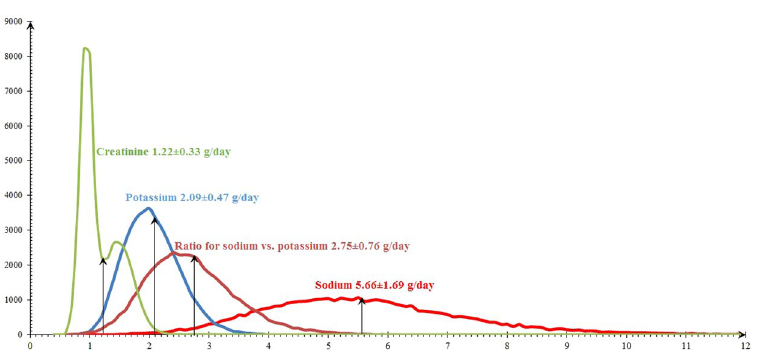
Figure 2. Distribution for 24-hour sodium, potassium, creatinine excretion, and ratio for sodium vs.